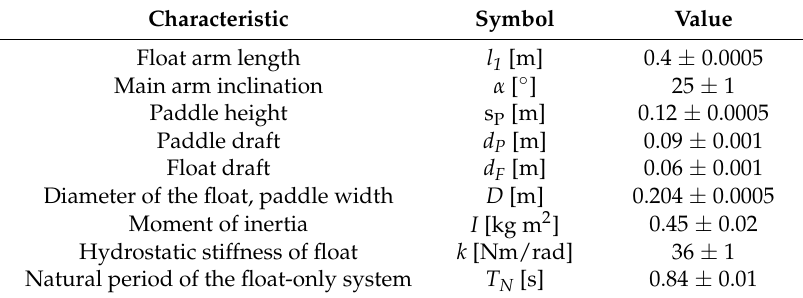
Table 1. Characteristics of the EDS laboratory model.